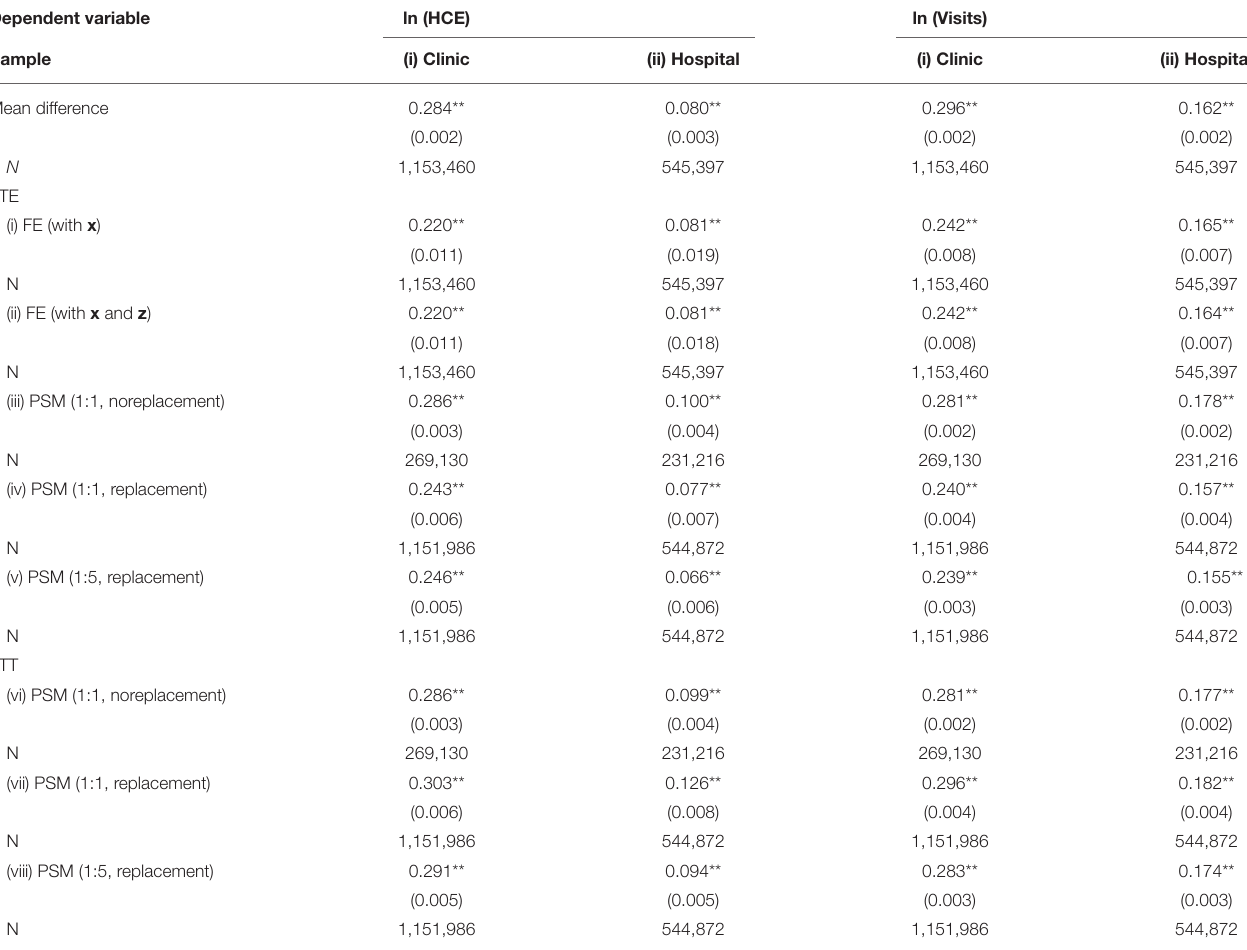
TABLE 5 | Effect of PA assignment on healthcare utilization by types of medical institutions. Dependent